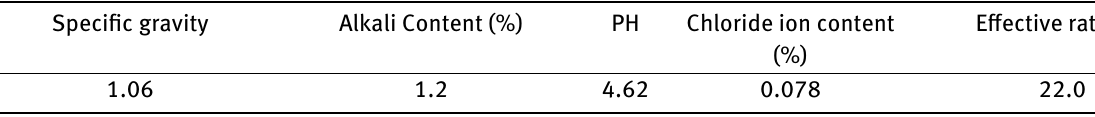
Table 4: High range water reducing admixture properties Specific gravity